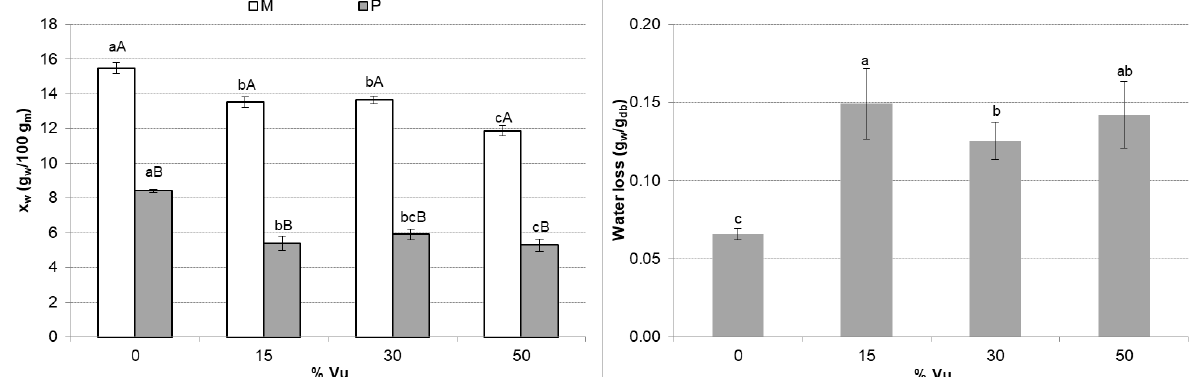
Figure 2. Mean values and standard deviation of moisture (x w ) of the mixtures (M) and powder (P), and the total water loss (W L ) of the process. For each parameter, the same small letter indicates homogeneous groups established by ANOVA ( p < 0.05) by comparing the Vu percentages (0, 15, 30, and 50). For each Vu percentage (0, 15, 30, and 50) and parameter, the same capital letter indicates homogeneous groups established by ANOVA ( p < 0.05) by comparing M and P.